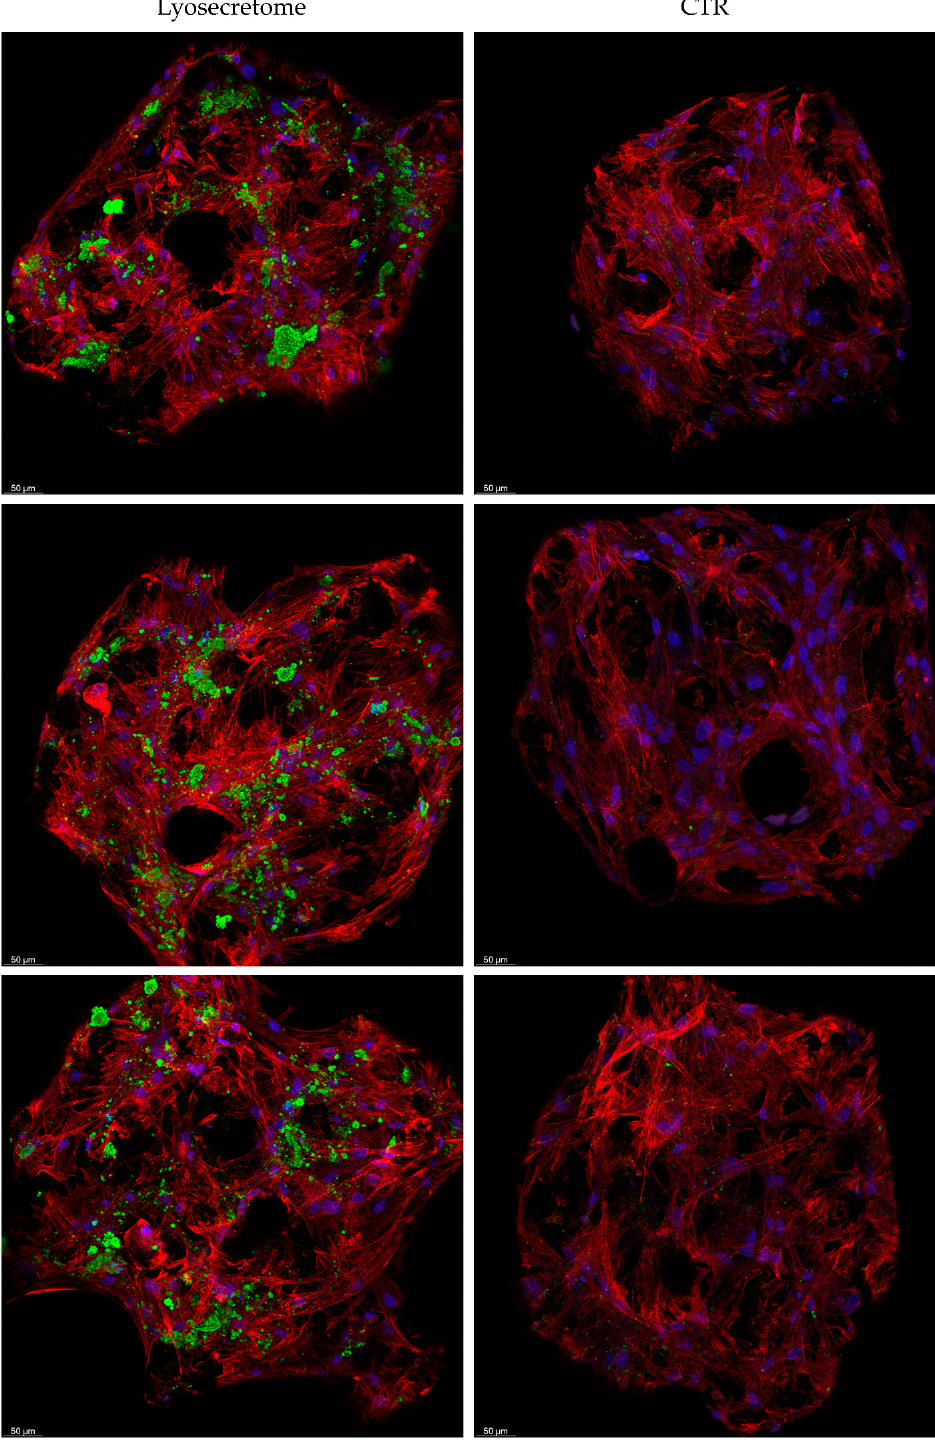
Figure 9. Confocal microscopy images of titanium cages seeded with MSCs and cultured in osteogenic medium with Lyosecretome or without (CTR) for 56 days. Cell nuclei are stained in blue; actin cytoskeleton is stained in red, and mineralized matrix is stained in green. Images are from three different biological replicates. Scale bar: 50 µm.